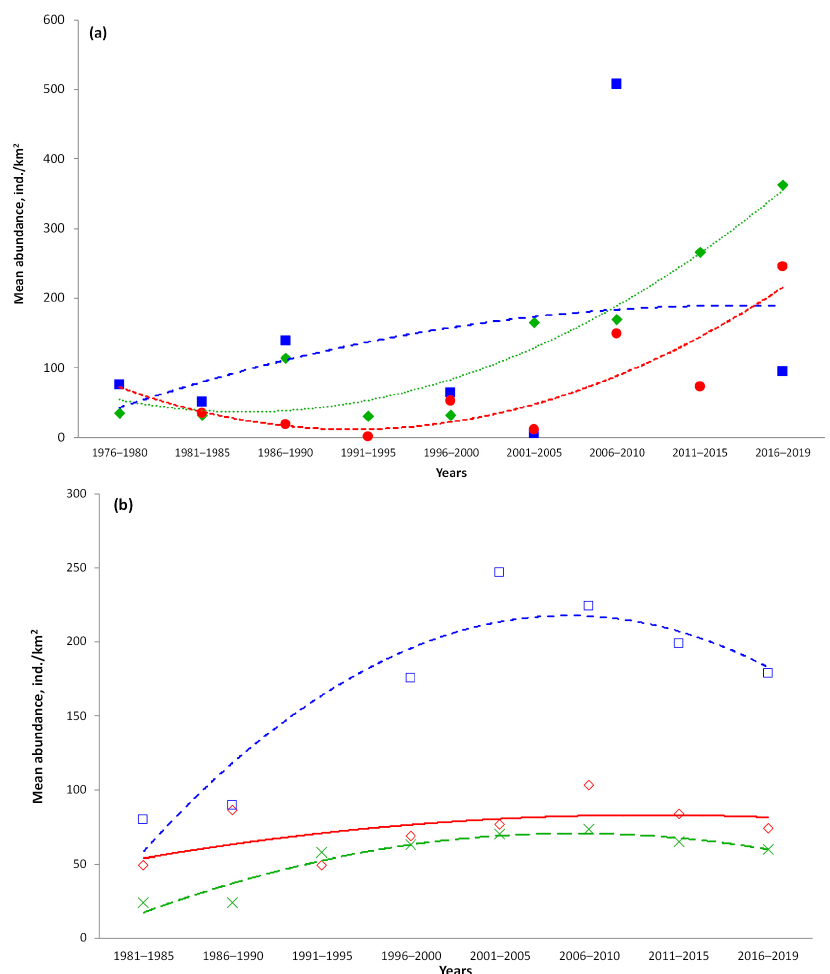
Figure 16. Region-specific dynamics of the abundance of the Aleutian skate Bathyraja aleutica from the North Pacific by year: ( a ) Russian waters and ( b ) Alaskan waters. Mean values and trends: ( ♦ , ··· ···) Western Bering Sea; ( , - -) NWPO; ( ● , ---) Sea of Okhotsk; ( ◇ ) Aleutian Islands; (x, ---- ) Gulf of Alaska; ( □ , ···) Eastern Bering Sea.